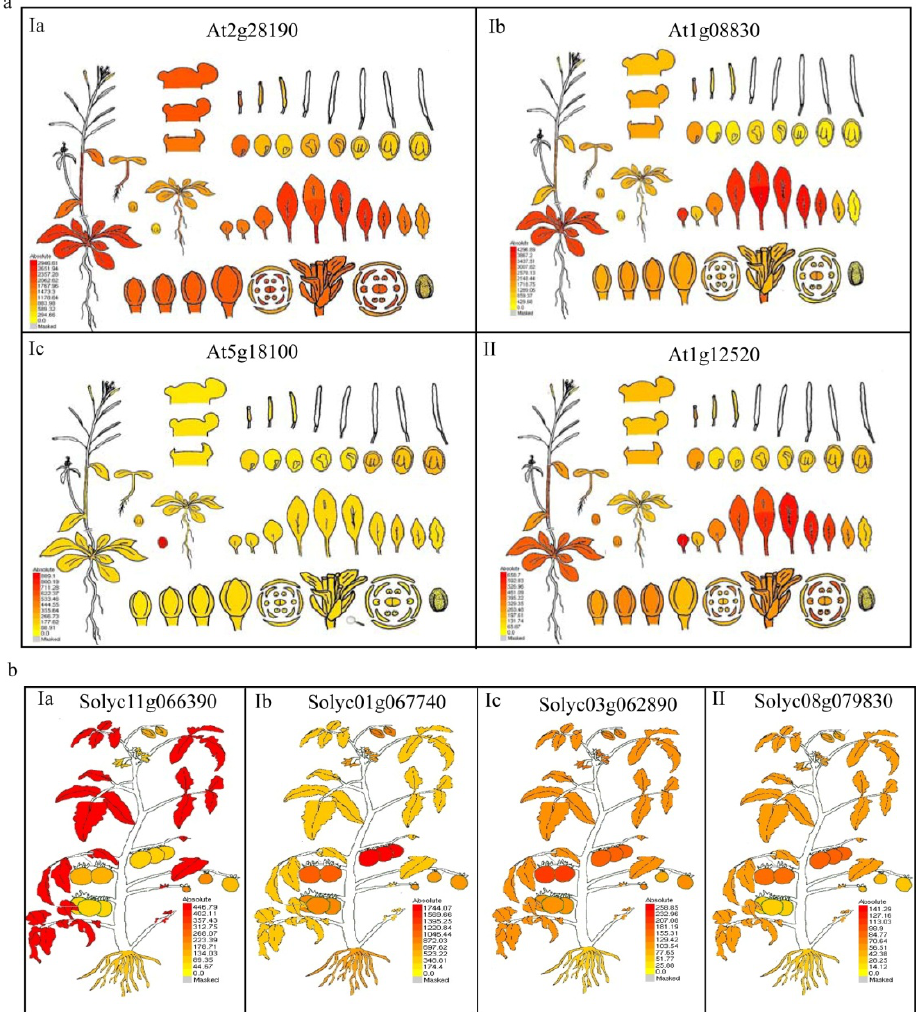
Figure 6. Expressions of Cu/Zn SOD genes during the growth and development of Arabidopsis thaliana ( a ) and Solanum lycopersicum ( b ). The gene is indicated in each graph. Detailed expression levels in various tissues and organs are indicated in a database online (http://bar.utoronto.ca/efp/cgi-bin/efpWeb.cgi, accessed on 14 December 2021).